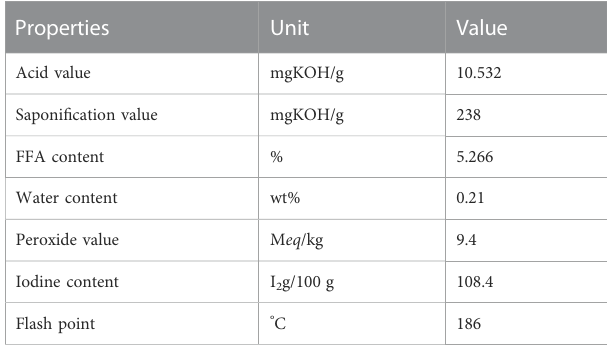
TABLE 1 Charateristics of Crude J. curcas